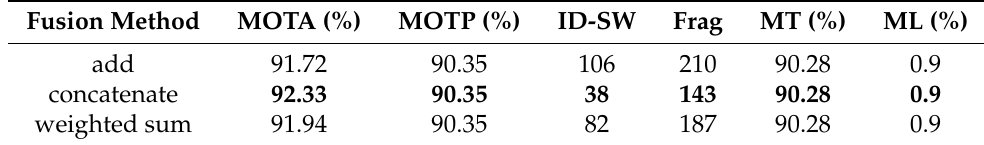
Table 2. Effectiveness of different fusion